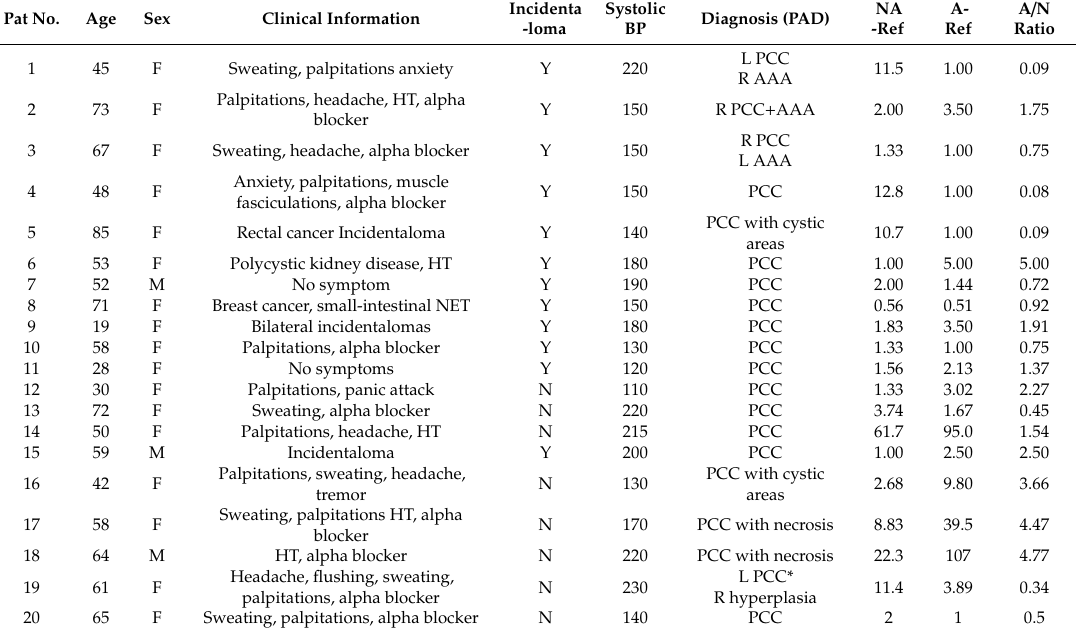
Table 3. CT characteristics and 11 C-HED-PET / CT parameters in the 20 patients with histopathologically confirmed pheochromocytoma (PCC) including 19 who were correctly characterized by 11 C-HED-PET / CT and one false negative 11 C-HED-PET / CT result (*). HT; hypertension, NET; neuroendocrine tumor, BP; blood pressure, CECT; contrast-enhanced CT, AAA; adrenocortical adenoma, L; left, R; right, A; epinephrine, NA; nor-epinephrine, A-Ref; ratio of value and upper normal reference range value, NA-Ref; ratio of value and upper normal reference range value.